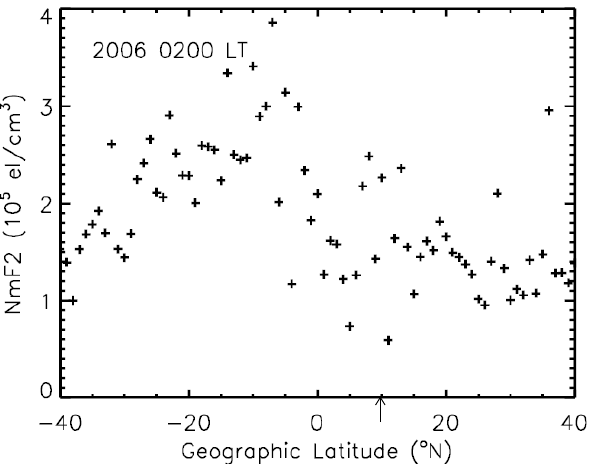
Fig. 8. GOX Nm F2 over Taiwan longitude (121 ◦ E) at 02:00LT in December 2006. The arrow denotes the magnetic